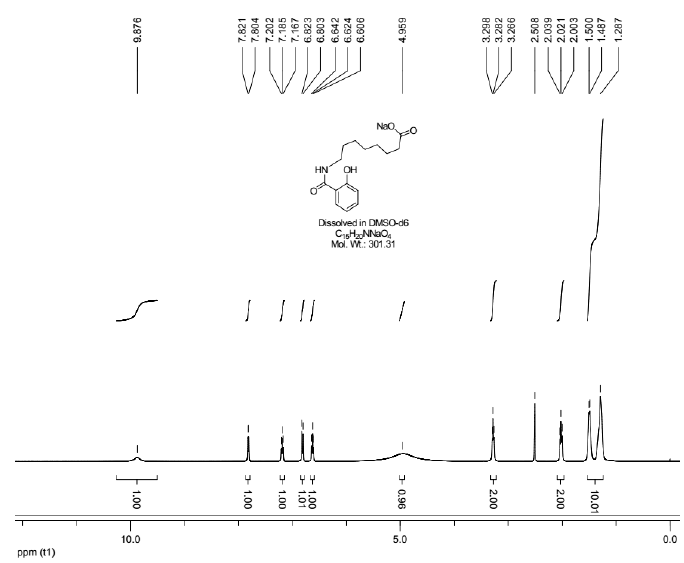
Figure 2. 1 H-NMR characterization of SNAC.